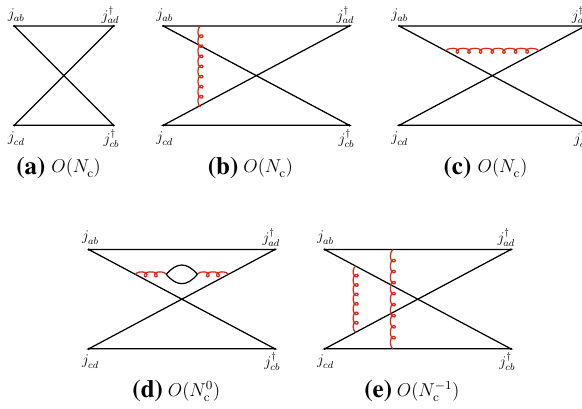
Fig. 2 Leading- and typical subleading-order diagrams of the “recom- bination” channel of Eq. (2.3)